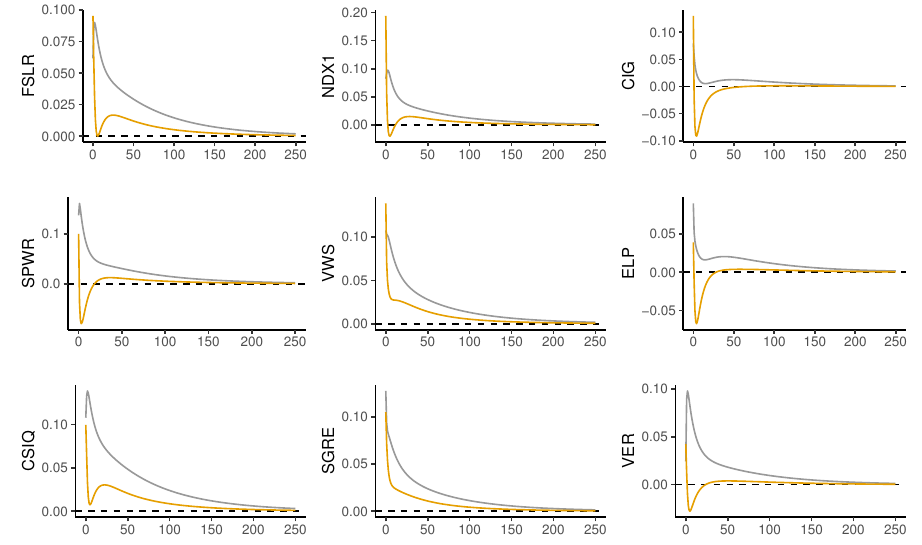
Figure 5. Impulse–response analysis of clean energy stocks, clustered by sector of production, when faced with a shock in VIX (gray line) and in VSTOXX (orange line) one year ahead (250 days). The left, center, and right columns correspond to solar, wind, and hydroelectric energy companies,